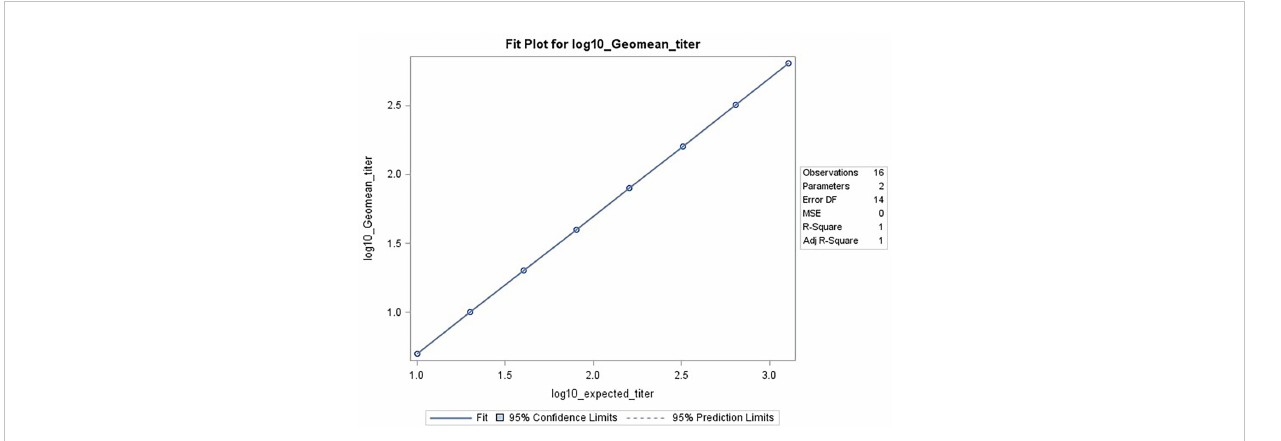
FIGURE 6 HAI assay quali fi cation on H3N2 in fl uenza strain A/Texas/71/2017, range testing results. The plot shows SAS output from REG procedure, showing the linear regression analysis between the expected [plotted on x-axis] and observed log10 GMTs [plotted on y-axis]. The resulting R 2 and R was 1.